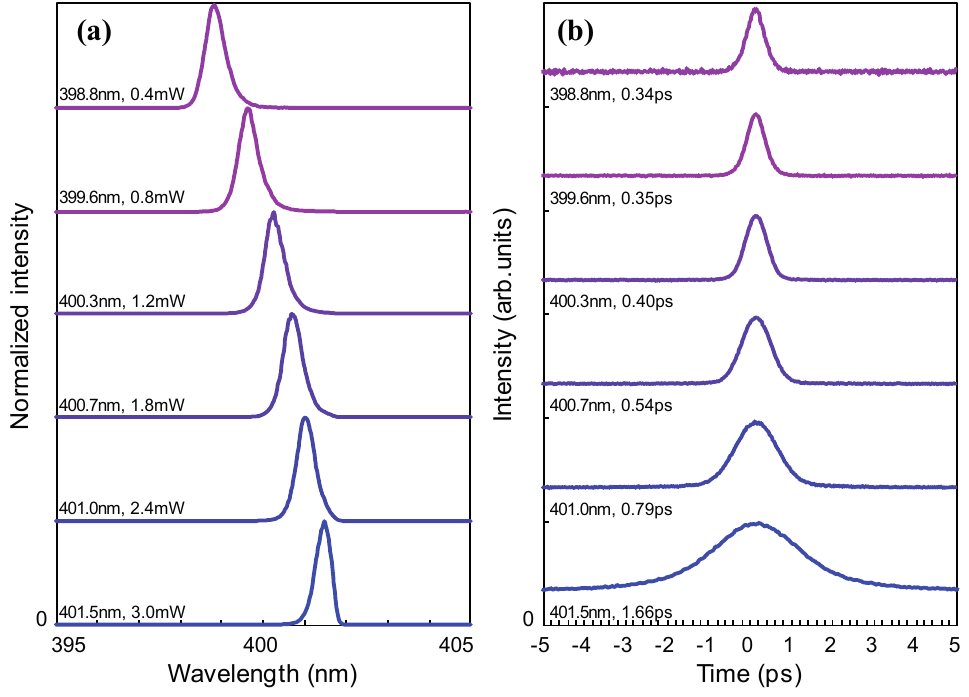
Figure 6. ( a ) Spectral components after the BPF with different transmission wavelengths and average power after the BPF; ( b ) Intensity autocorrelation traces corresponding to the spectral components after the BPF with pulse durations assuming sech 2 pulse